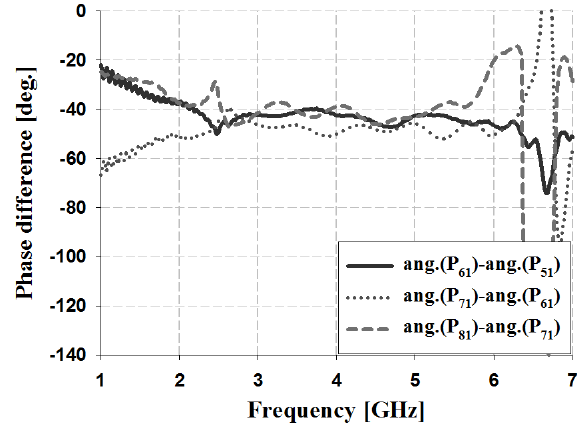
Sensors 2019 , 19 , x FOR PEER REVIEW 13 of 21 Figure 19. Measurement analysis of phase di ff erence for input Port 1. Figure 19. Measurement analysis of phase difference for input Port 1. Figure 19. Measurement analysis of phase difference for input Port 1.